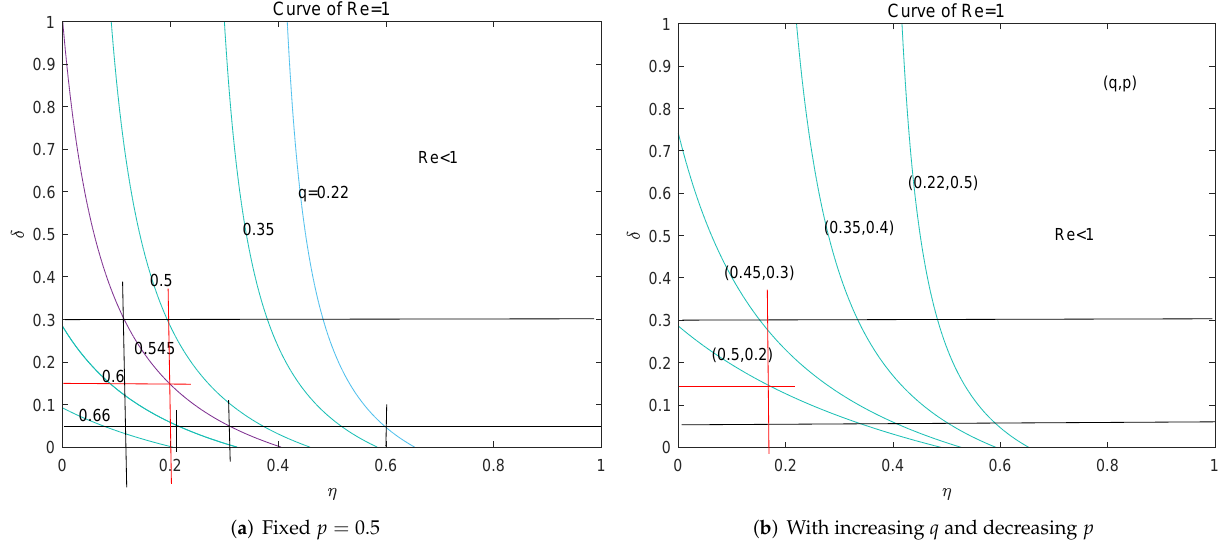
Figure 6. Investigations on curves of R e ( t ) = 1 with interventions. ( a ) It is possible to keep ( t ) = 1 with interventions